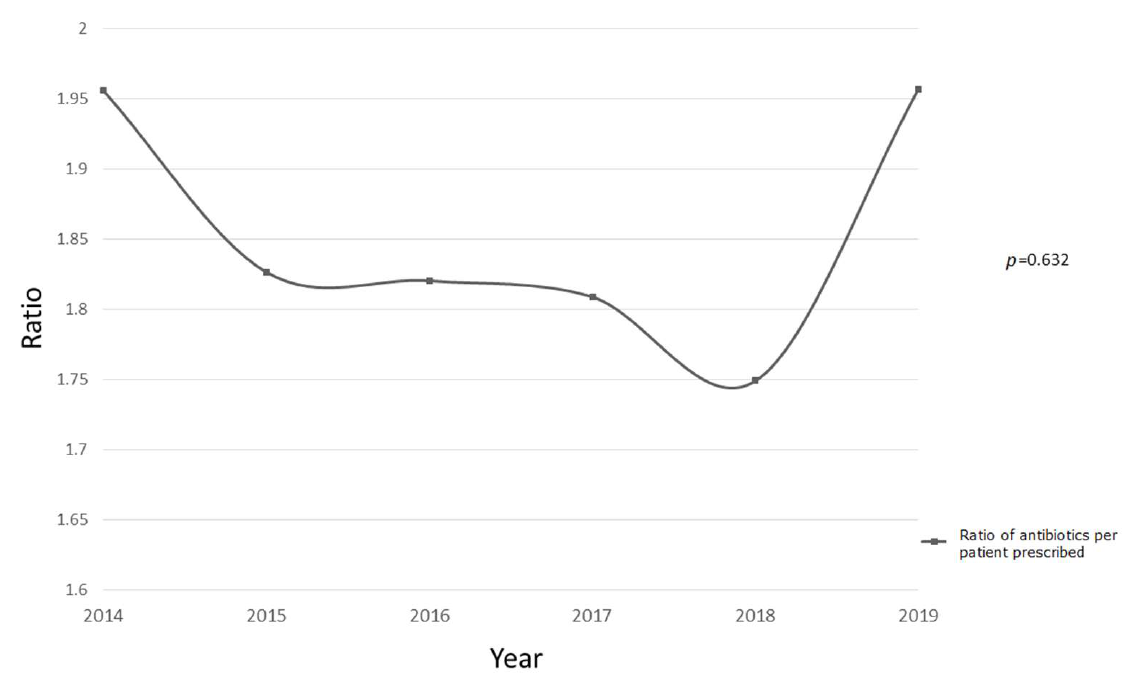
Figure 1. Evolution of the ratio for the number of antibiotics per patient prescribed antibiotics. Comparison of proportions between 2014–2016 vs. 2017–2019 expressed as p -values. Table 3. Comparison between the two periods regarding the different reasons for antibiotic indications. Type of Antibiotic Indication, n (%)